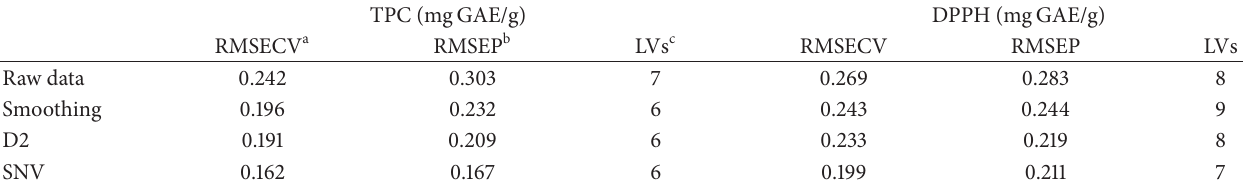
Table 1: Results of full-spectrum PLS (FS-PLS) models for predictions of antioxidant activity of brown rice.